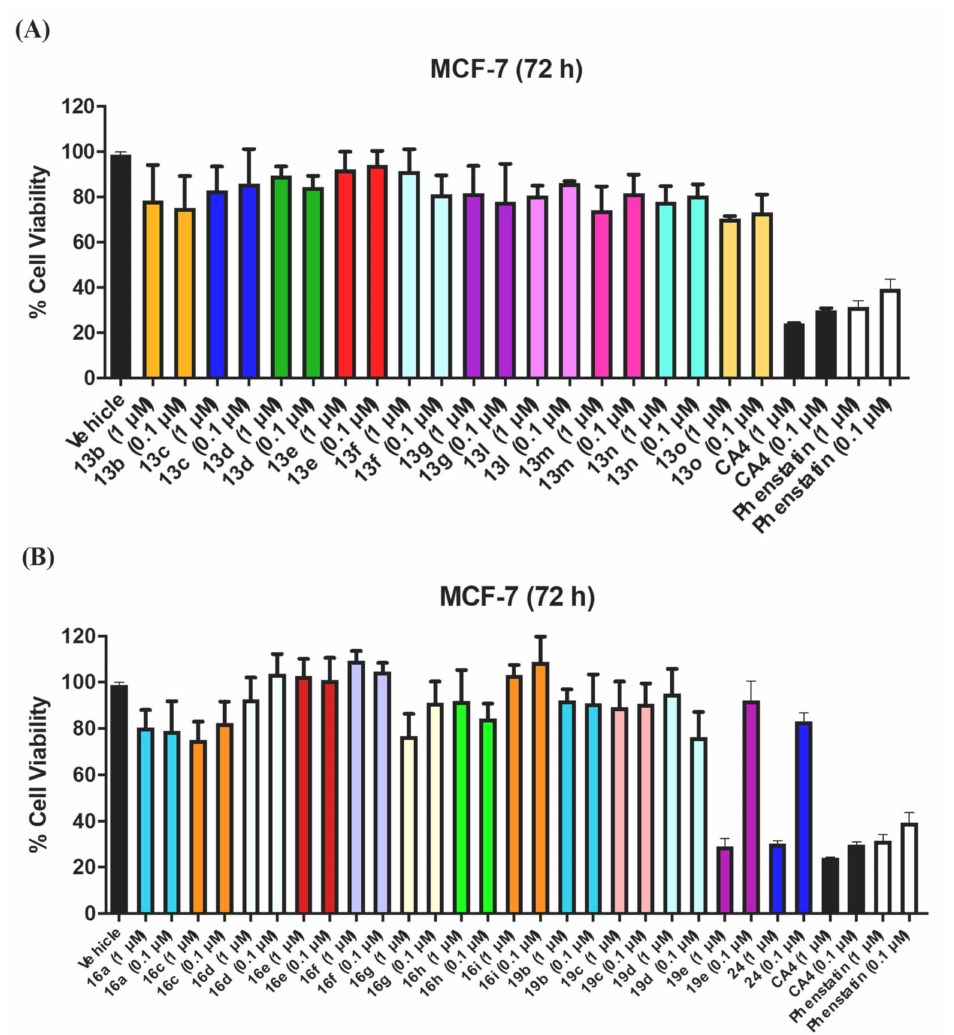
Figure 4. Preliminary cell viability data for ( A ) Series 1: 1-(diarylmethyl)-1 H -1,2,4-triazoles 13b–g , l–o ( B ) Series 2: 1- (diarylmethyl)-1 H -1,2,4-triazoles 16a , c–i , 19b–e , 1-(diarylmethyl)-2 H -1,2,3-triazole 24 in MCF-7 breast cancer cells. Cell proliferation of MCF-7 cells was determined with an alamarBlue assay (seeding density 2.5 × 104 cells/mL per well for 96-well plates). Compound concentrations of either 1 or 0.1 µ M for 72 h were used to treat the cells (in triplicate) with control wells containing vehicle ethanol (1% v / v ). The mean value + SEM for three independent experiments is shown. The positive controls used are CA-4 and